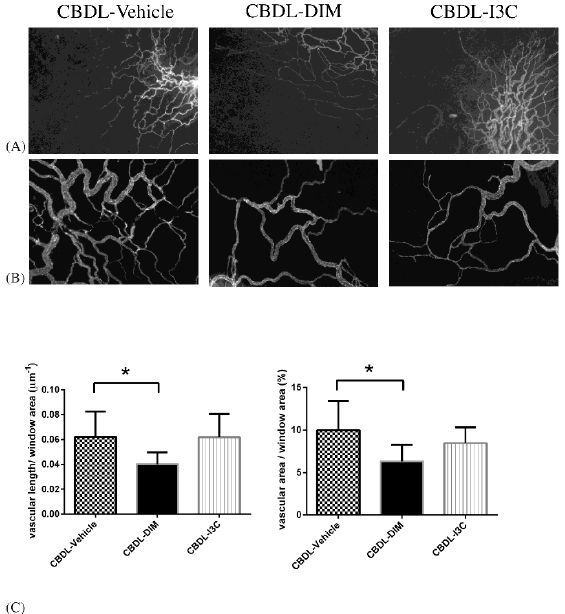
Figure 2. Representative images of CD31-labelled mesenteric window microvascular networks in CBDL rats treated with vehicle, DIM, or I3C: ( A ) The magnification 40×, ( B ) the magnification 100×. ( C ) The vascular density of different experimental groups analyzed with ANOVA under the magnification 100×. DIM markedly decreased the vascular length (* p < 0.05, DIM vs. vehicle) and vascular area of mesenteric window (* p < 0.05, DIM vs. vehicle).